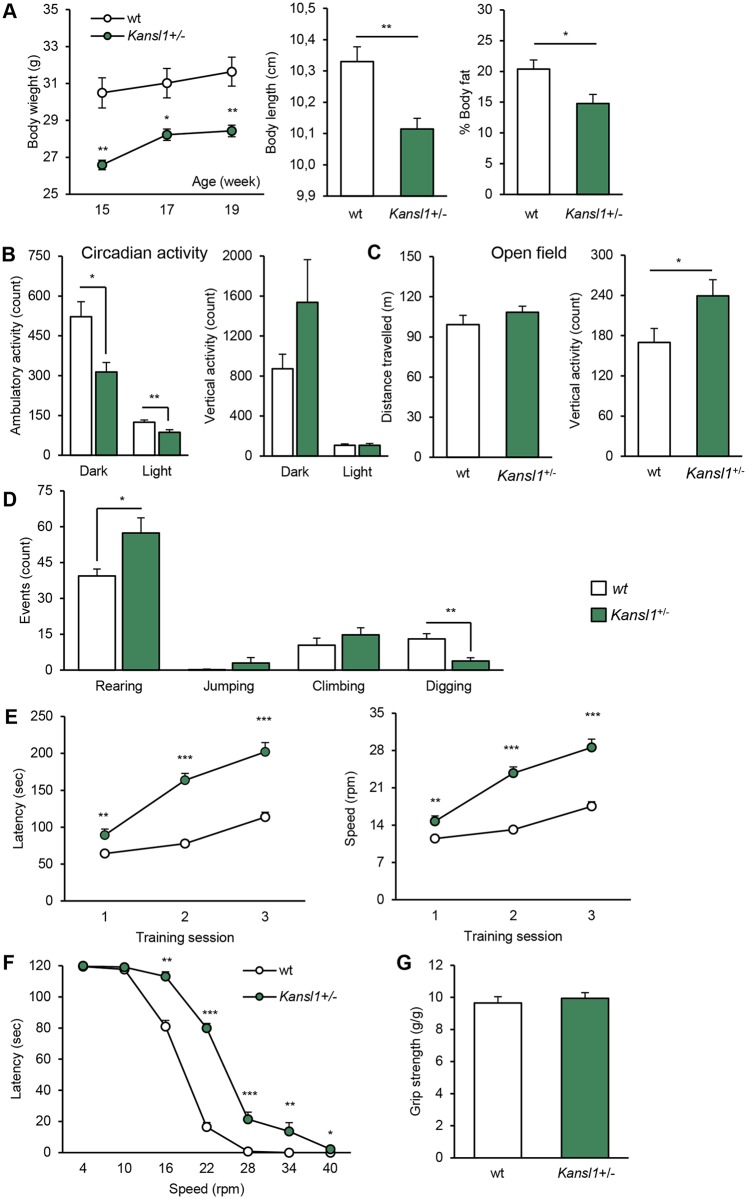
General behavioral characterization of Kansl1+/- cohorts.(A) Body weight (g) of adult animals at 15, 17 and 19 weeks of age with Body length (distance from snout to tail basis) and Body fat percentage measured by qNMR of 20-week-old animals. Compared to wt littermates, Kansl1+/- animals show body weight, size and adiposity deficits. (B) Circadian activity test. Graphs plot the spontaneous ambulatory activity (count) and the vertical activity/rears (count) during dark and light phases. (C) Open field test. Distance travelled (m), and vertical activity/rears (count) over 30 min of testing. (D) Repetitive behaviors. Graph plots occurences of rearing, jumping, climbing and digging behaviors (count) during 10 min of observation in a novel home cage. Kansl1+/- animals show increase of rearing and decrease of digging levels reflecting an alteration of exploration activity. (E) Results are expressed as the time (s) that mice remained on an accelerating rod before falling during the training phase over 3 consecutive days of the rotarod test. (F) Corresponding rotational velocity (rpm) at the time of falling during the challenge phase of the rotarod test. The graph plots the time (s) that mice stayed on the rod when tested at constant speeds between 4 and 40 rpm. (D) Four-paw grip test. The conclusion of the rotarod and grip tests is that Kansl1+/- animals show locomotor coordination improvements without alterations of muscular strenght. Graphs depict mean + s.e.m.. (B-D) Student’s t-test, *P < 0.05, **P < 0.01. (A, E-G) Repeated Measures ANOVA "genotype" analysis, Tukey's test, *P < 0.05, **P < 0.01, ***P < 0.001.